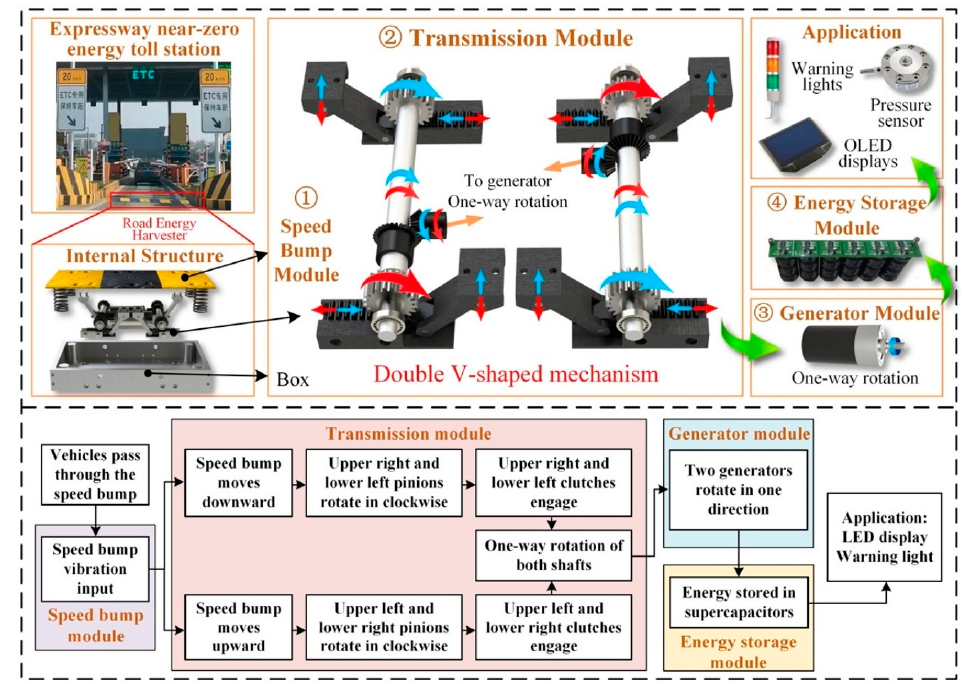
Figure 13. Design of electromagnetic energy scavenging module based on a double V-shaped mechanism [115]: the module’s structure, then a schematic of the elements (Reprinted with permission from Ref. [115]. 2021, Elsevier).